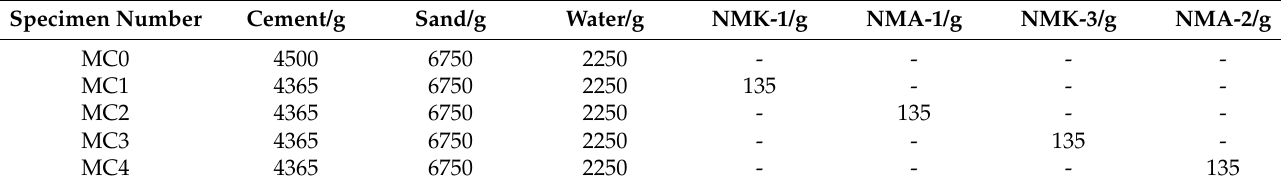
Table 4. Mix proportion of cement mortar.